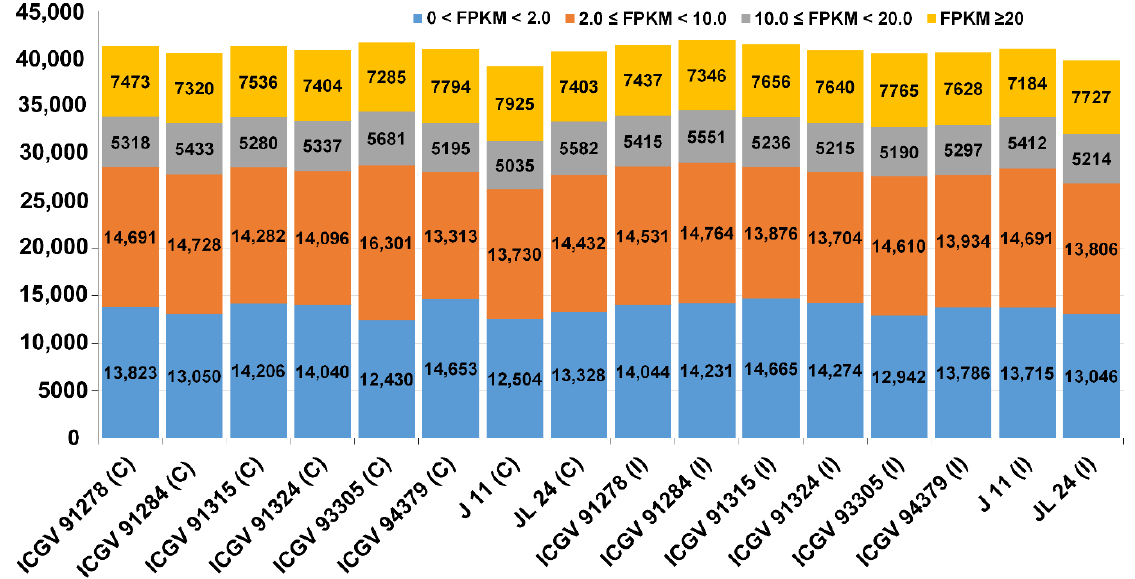
Figure 1. Distribution of genes expressed in 16 samples. Based on expression level, genes were grouped into four classes (FPKM < 2, 2 ≤ FPKM < 10, 10 ≤ FPKM < 20 and FPKM > 20) in sixteen samples.